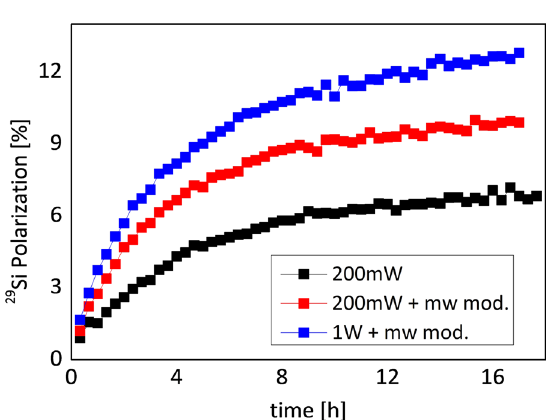
Figure 1. ( A ) TEM image of dry silicon nanopowder. ( B ) Size distribution obtained from 10 subsequent TEM images.